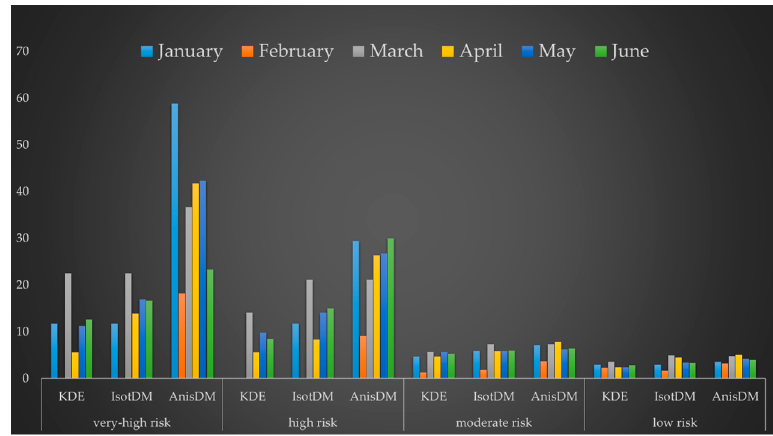
Figure 13. Monthly prediction accuracy index (PAI) of IsotDM and AnisDM.